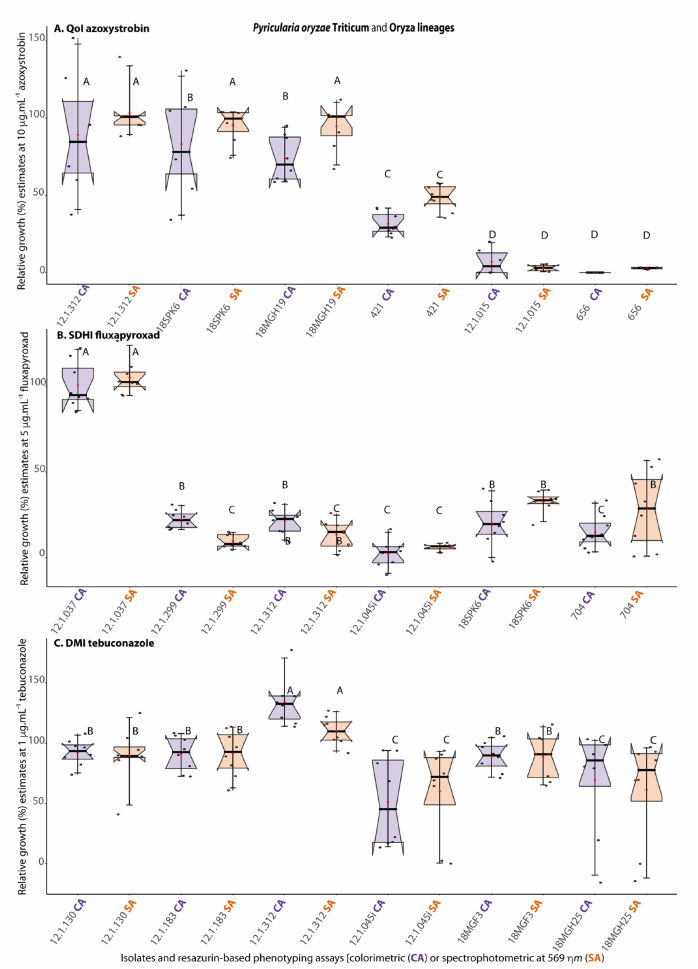
Figure 7. Correspondence between fungicide resistance categories (based on relative growth es- timates) as a measure of accuracy of the resazurin-based colorimetric assay (COL-assay, purple boxplots) in comparison with the classical spectrophotometry detection assay (SPEC-assay, orange boxplots) for testing sensitivity of Pyricularia oryzae Triticum (PoTl) or P. oryzae Oryza lineage (PoOl) to QoI, ( A ), SDHI ( B), and DMI ( C ) fungicides a,b . a The COL-assay was based on analyses of digital images of experimental microplates captured with mobile phone cameras on a handmade trans- illuminator designed for colorimetric estimation of RZ reduction from T 0 to T 4 using the ReadPlate3.0 in ImageJ developed by Delfino [21], as described in item 2.6 from this study. b The figure depicts boxplots with the medians represented by black lines across the notches, the average as red circles along the whisker lines, and the jittered data points in purple or orange to avoid data overplotting. The F statistics for treatment effect was significant at least at p ≤ 0.05. Boxplots with the same letter on top (from A to D) indicate that the means for the particular isolate or resazurin-based phenotyping assay are not significantly different by the Scott–Knott test at α ≤